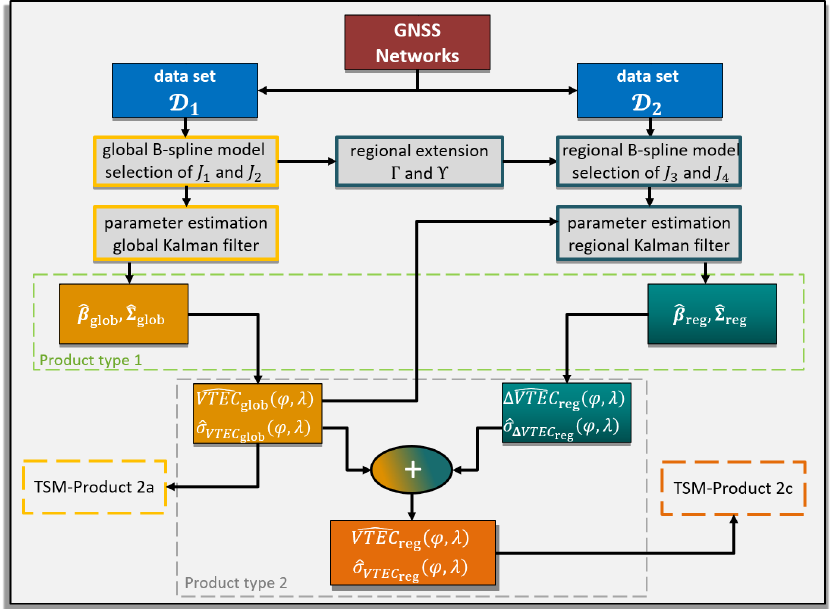
Figure 2. Flowchart of the two-step model (TSM), with the process chain for the first step—the global model—on the left side in yellow and the process chain for the second step—the regional densification—on the right side in